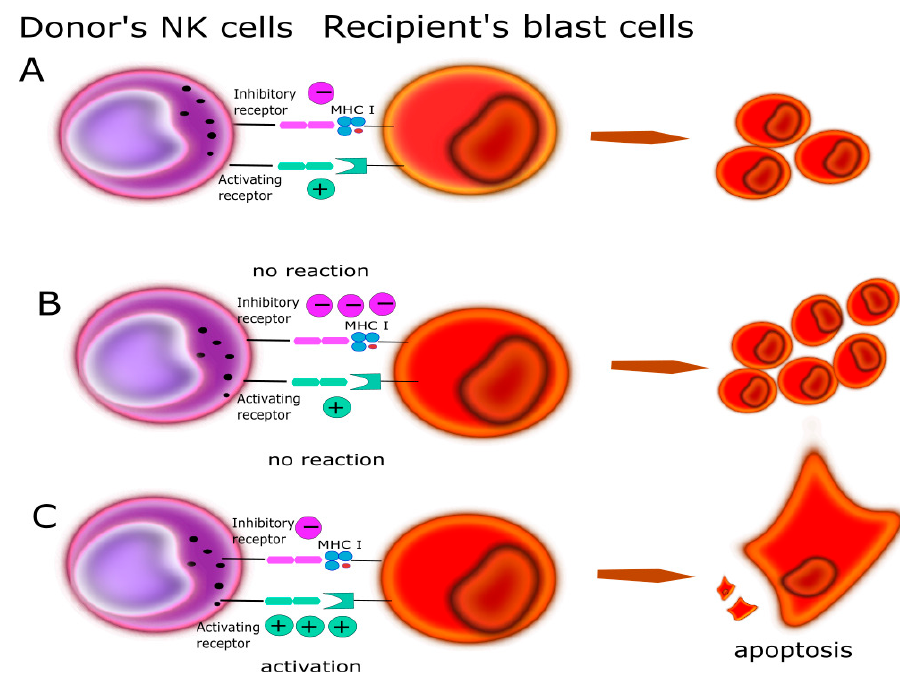
Figure 6. Relationship between KIR/HLA antigens could play a main role in GvL determined by the balance of activating and inhibitory input. ( A ) The recipient and donor are matched in a way that the final charge is balanced and does not induce cytotoxic activity in NK. ( B ) The recipient and donor are selected that does not induce NK cytotoxic activity; more inhibition signals. ( C ) The recipient and donor are selected that NK cytotoxic activity and leads to kill blast’s cells.